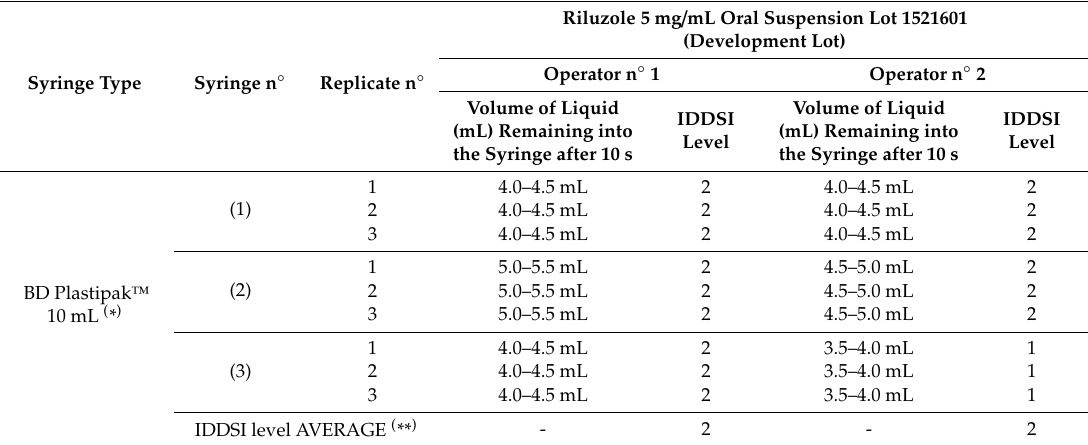
Table 3. Riluzole 5 mg / mL oral suspension (lot 1521601): IDDSI Flow Test.